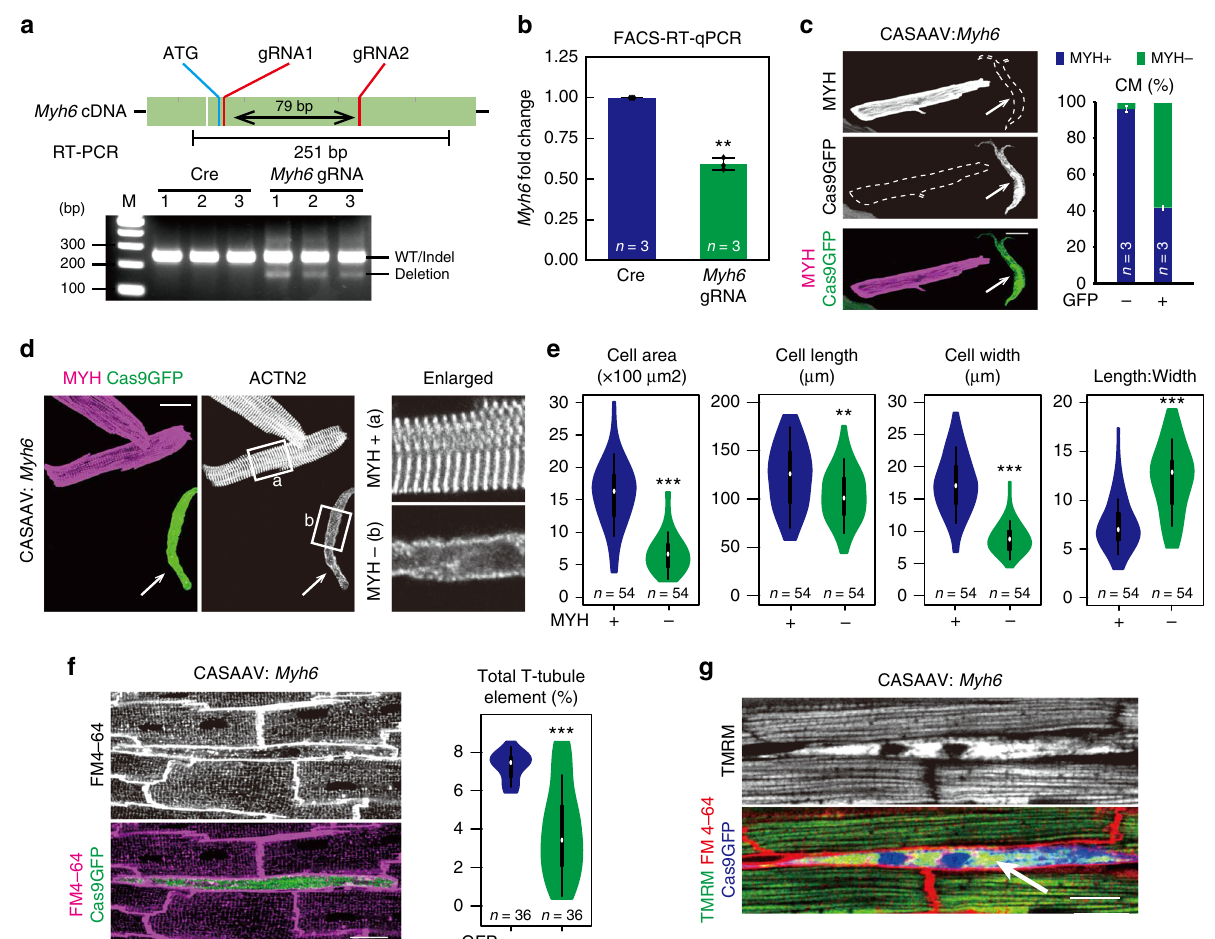
Fig. 6 Sarcomere assembly is essential for other aspects of CM maturation. a CASAAV ablation of Myh6 . Dual gRNAs targeting the fi rst coding exon of Myh6 gene induced Cas9-mediated deletion of the intervening genomic region when delivered to P1 CMs using the CASAAV system. Deletion validation and phenotypic analyses were performed at P14 and 1 month after injection, respectively. Deletion was monitored by RT-PCR. b Validation of Myh6 depletion. After CASAAV-based neonatal Myh6 mutagenesis, FACS-sorted GFP + CMs at P14 were used to quantify Myh6 by RT-qPCR. c Identi fi cation of individual CMs with successful MYH6 depletion by myosin heavy chain (MYH) immuno fl uorescence staining (arrow). Cell boundaries were delineated by dashed lines. The fraction of cells that were depleted of MYH was quanti fi ed to the right. d Sarcomere loss in CMs depleted of MYH6. After Myh6 CASAAV, dissociated CMs were stained for ACTN2. Arrow points to a MYH-depleted CM. Boxed regions are enlarged to the right. e MYH6 depletion disrupted maturational hypertrophic growth of CMs. MYH6-depleted CMs were identi fi ed by immunostaining. f MYH6 depletion disrupted T-tubulation. T-tubule organization was measured by in situ imaging and AutoTT quanti fi cation. Representative image shows defective T-tubules within a Cas9GFP + cell. g MYH6 depletion caused mitochondrial disorganization. Mitochondria were imaged in situ by TMRM staining. GFP − cells (no blue pseudocolor) had highly organized arrays of mitochondria, unlike the mitochondrial staining pattern in GFP + cells (arrow). Scale bars, 20 μ m in all images. Violin plots are described in Fig. 2. Bar plots show mean ± SD and are overlaid by dot plots. Numbers in bar indicate sample size. Two-tailed Student ’ s t test: ** P < 0.01, *** P <